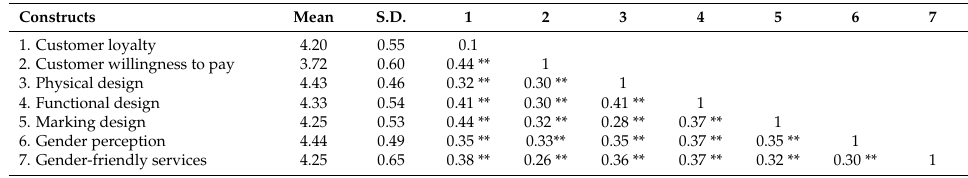
Table 5. Means, standard deviations, and Pearson